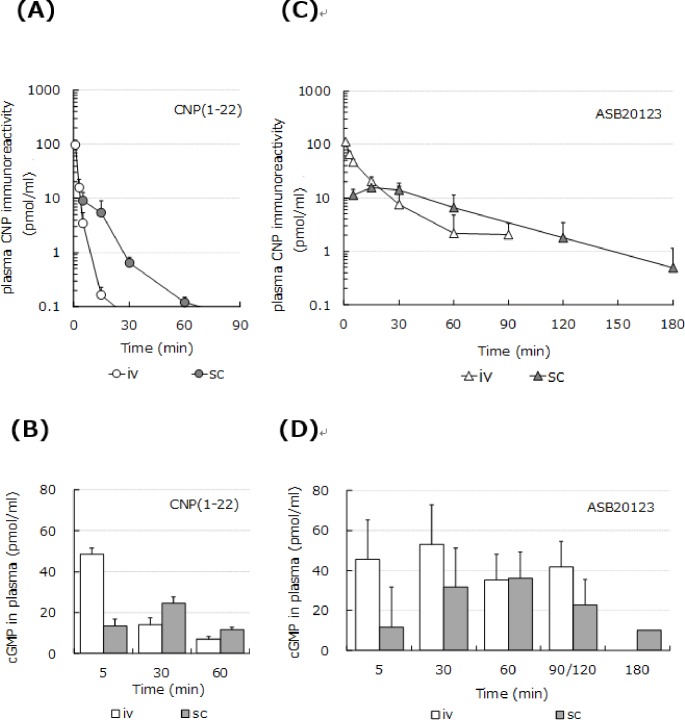
PK/pharmacodynamic profiles of CNP(1–22) and ASB20123 in rats.Plasma CNP immunoreactivity-time curves (the upper panels) and cGMP concentrations (the lower panels) after a single iv (20 nmol/kg) or sc (50 nmol/kg) dose of CNP(1–22) (A, B) or ASB20123 (C, D) in anesthetized rats. Each value represents the mean ± SD of 3 rats.